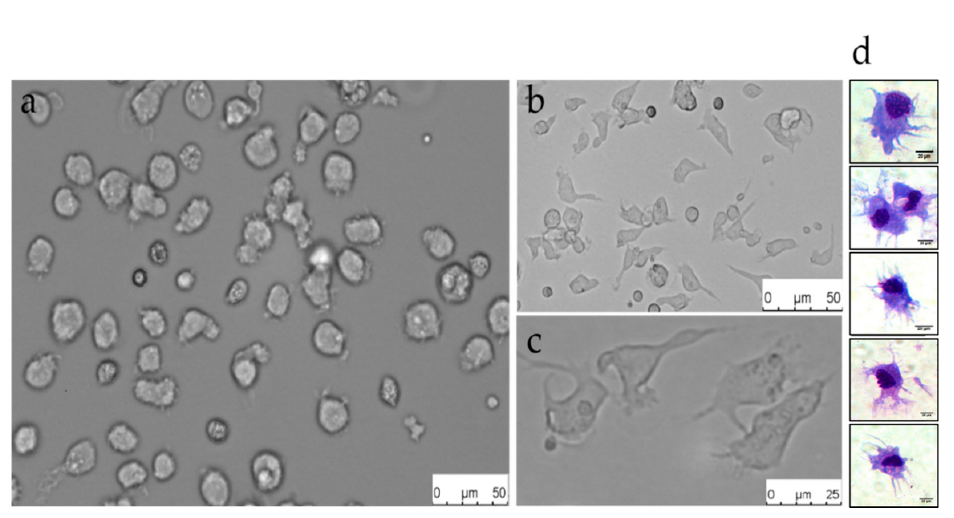
Figure 1. Culture and staining observation of grass carp dendritic cells (gDCs). ( a ) Isolated mononuclear cells at day 1 (scale bar = 50 μ m). ( b ) Cultures showing non-adherent cells with dendritic morphology (scale bar = 50 μ m). ( c ) Enriched cells with typical dendritic morphology (scale bar = 25 μ m). ( d ) Dendritic cells were stained using Giemsa showing typical dendritic morphology on these cells (scale bar = 20 μ m). Data are representative of at least three independent experiments ( n > 3).